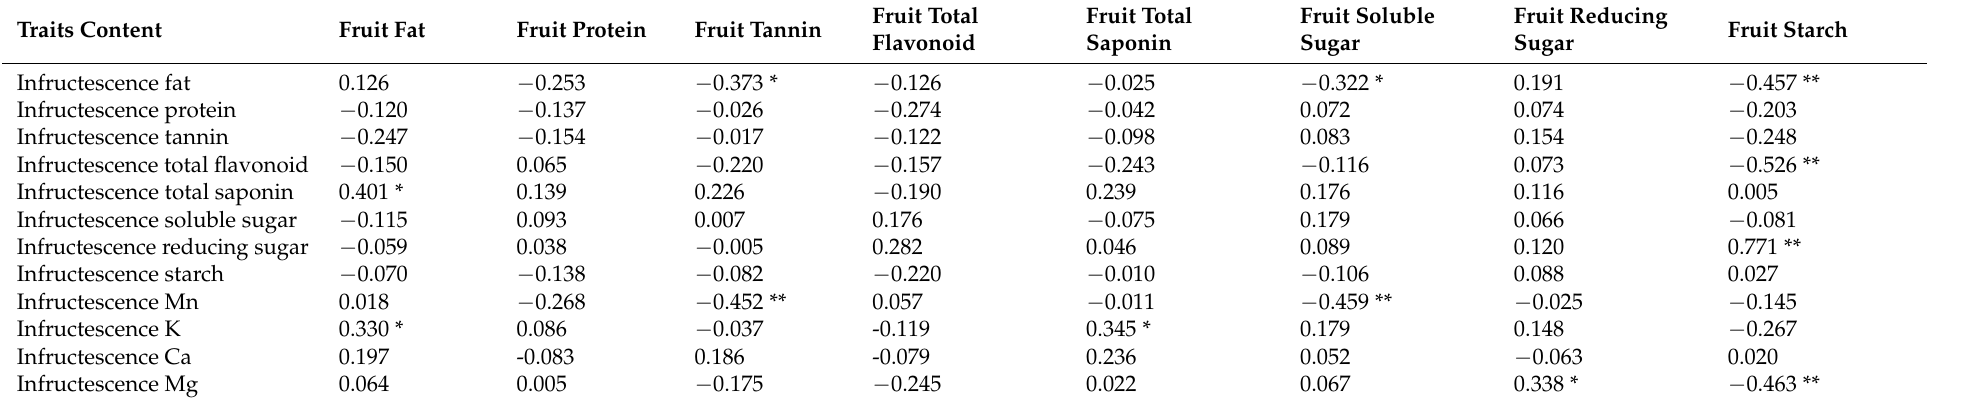
Table A3. Correlation analysis between infructescence and fruit quality traits of H. acerba germplasms.